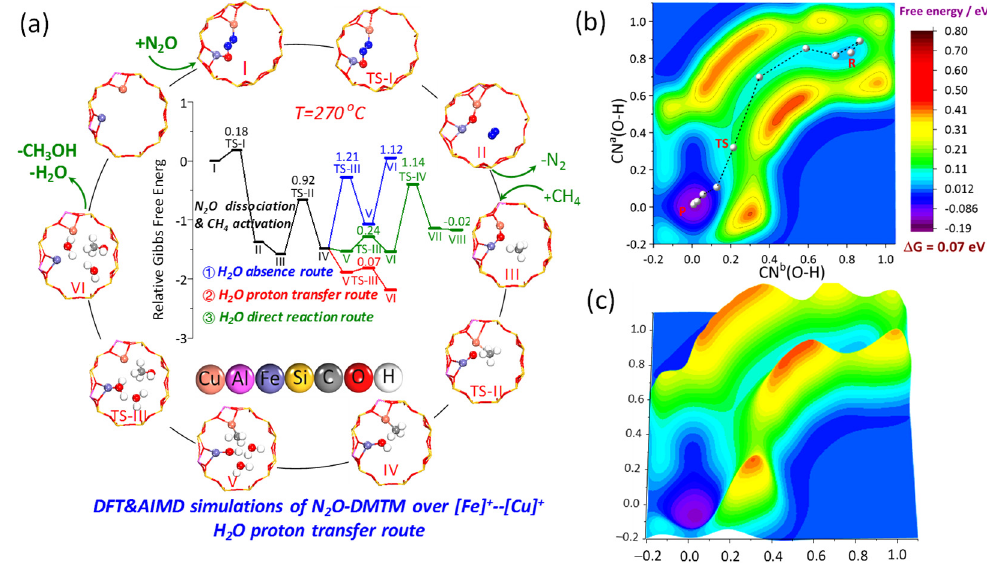
Figure 7. H 2 O-mediated N 2 O DMTM mechanism simulation results of the H 2 O proton-transfer route over Fe 0.6% Cu 0.68% -BEA with the neighboring bimetallic cation active site of [Fe] + –[Cu] + , wherein the initial N 2 O dissociation and CH 4 activation steps of (I → IV) were simulated by DFT, while the H 2 O proton-transfer route (V → VI) was simulated by AIMD; ( a ) derived free energy diagram along with the reaction coordinate (with the unadsorbed reactant and desorbed product being taken into account to obtain the net change of the reaction energy); metadynamics-computed free energy surface in a ( b ) 2D and ( c ) 3D view based on the AIMD, wherein the minimal free energy route is shown by gray balls in panel ( b ).